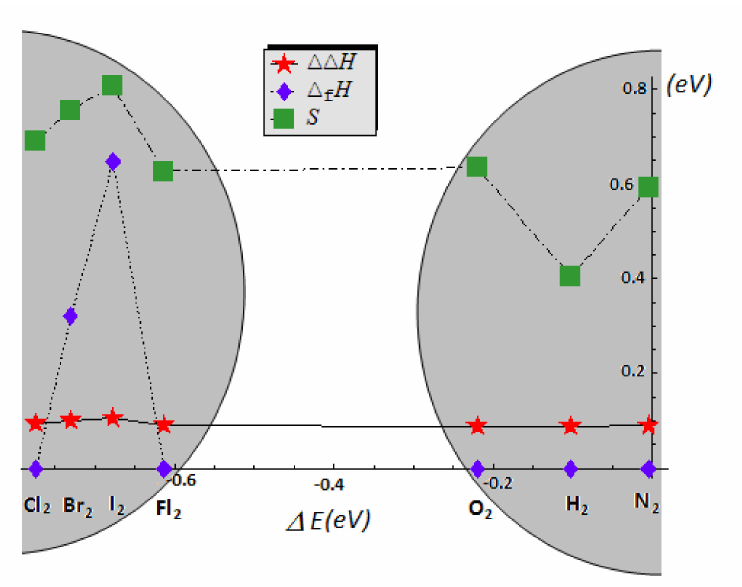
Figure 8. The same type of representations as in Figures 5 and 6, yet for the homonuclear diatomics of Table 4. Only the COS values are provided since all PP values vanish according to Table 1 for homonuclear